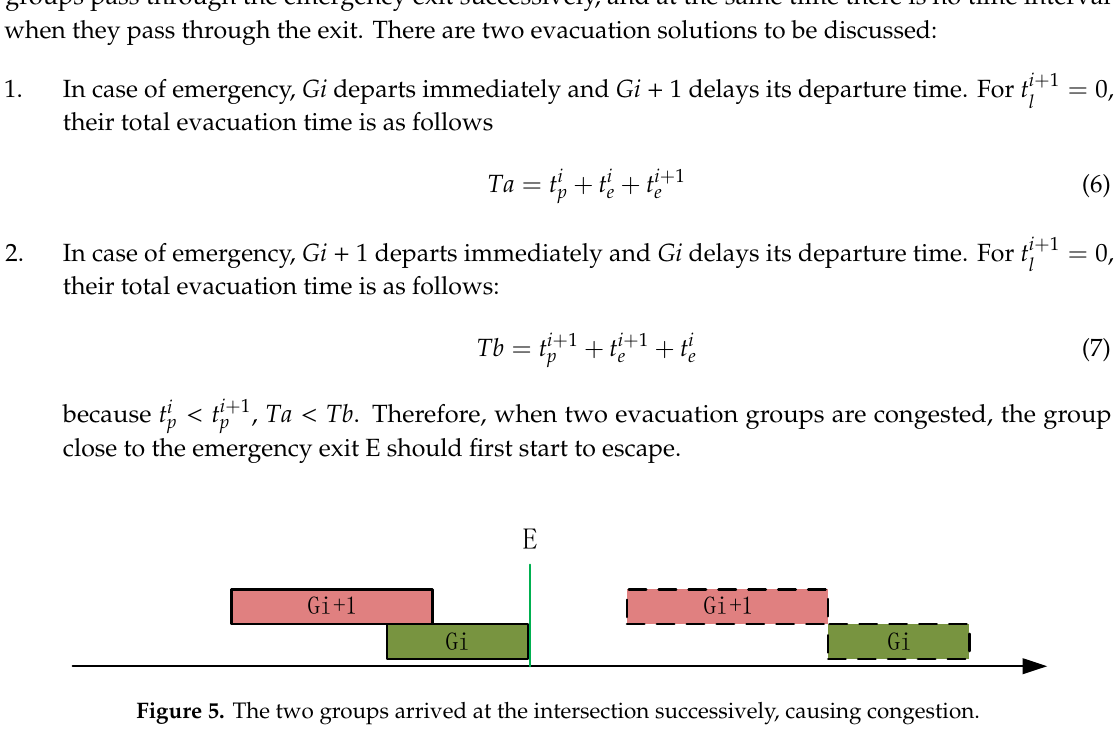
Figure 5. The two groups arrived at the intersection successively, causing congestion.